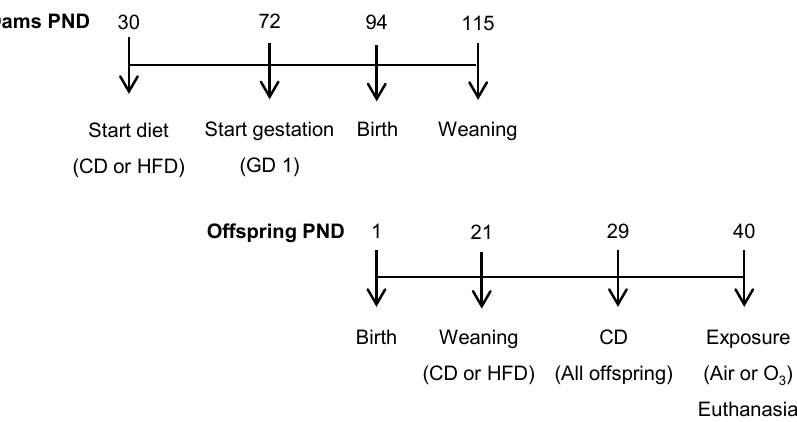
Figure 7. Experimental design. PND—postnatal day; GD—gestational day; CD—control diet; HFD—high-fat diet; O 3